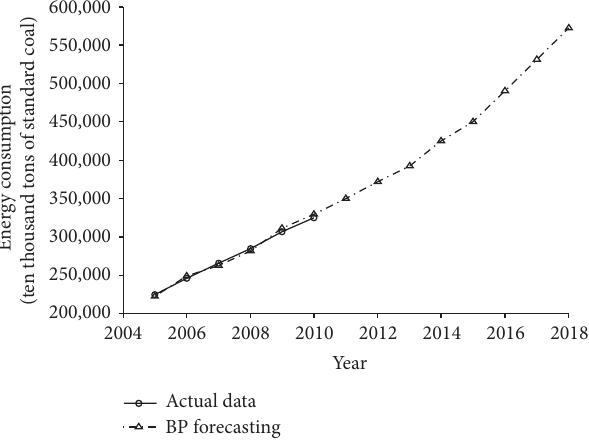
Figure 3: Forecast of China’s energy consumption by